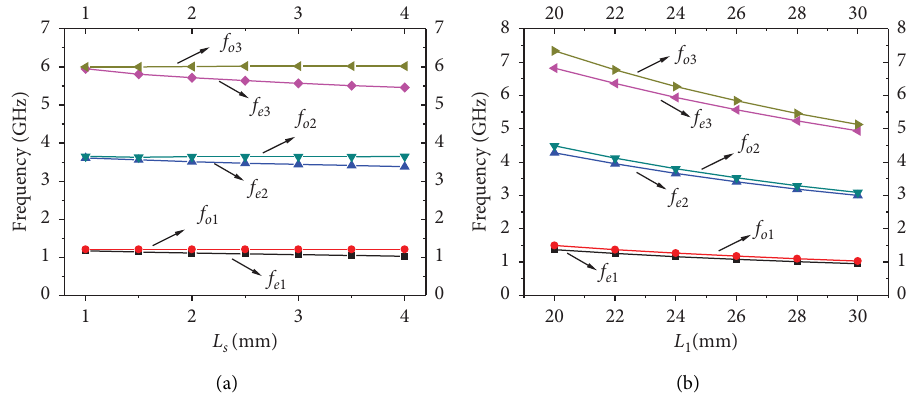
Figure 5: Variation of frequency with different L